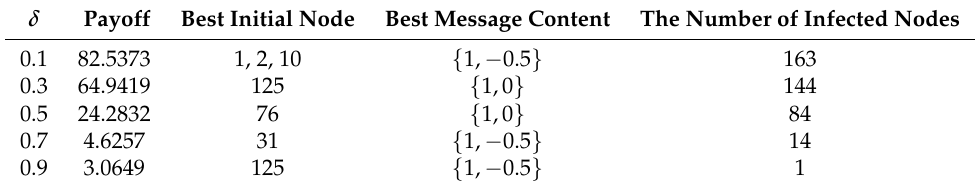
Table 8. Only player 1 forwarding its message to the network.